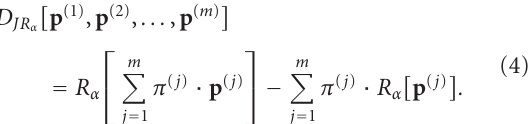
Figure 4: Histograms of the lengths of coding DNA regions.